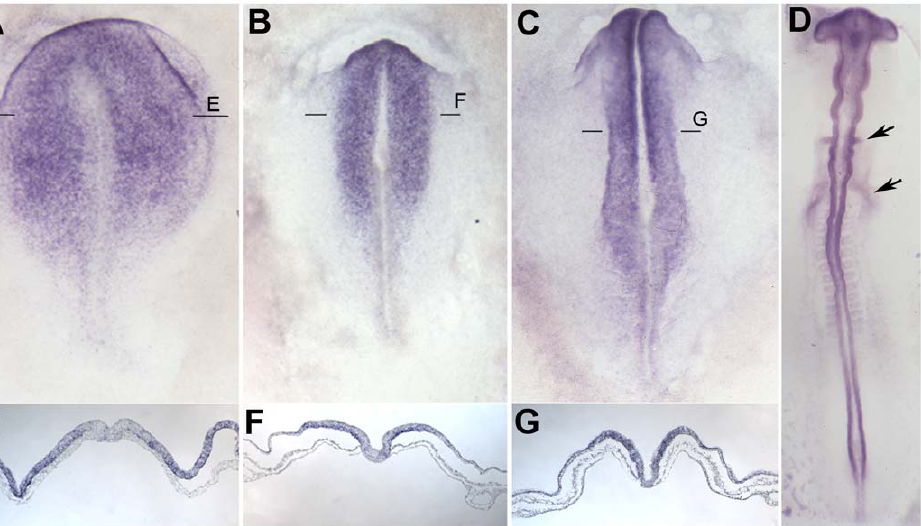
Figure 4. Obelix expression during early development. Expression of Obelix by in situ hybridization at stages 3 + (A), 5 (B), 7 (C) and 11 (D). E–G are sections through the levels shown in A–C. Expression is localized in the neural plate, neural tube and their derivatives.